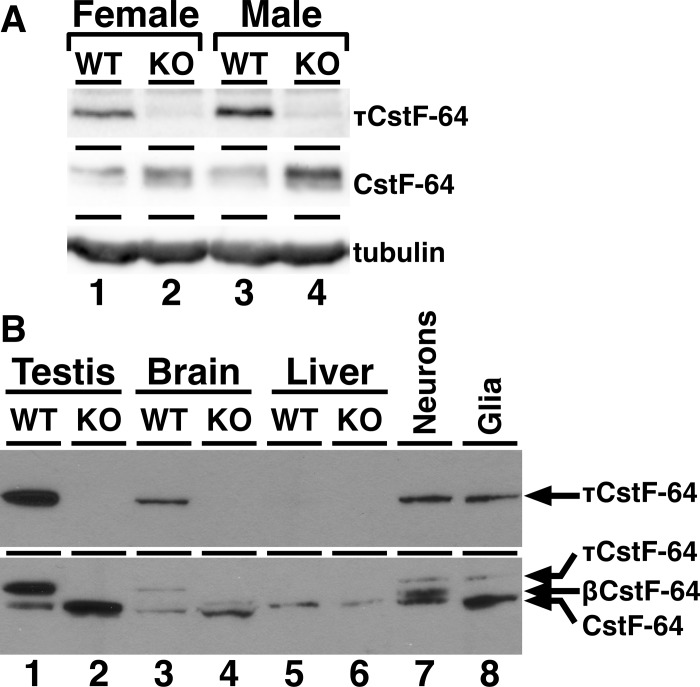
τCstF-64 and CstF-64 are expressed in brains of adult mice.(A) Brain tissue extracts were separated by 10% SDS-PAGE and probed with antibodies that recognized τCstF-64 (Bethyl A301-487A, top panel), CstF-64 (3A7, middle panel), or β-tubulin (E7, bottom panel). Lanes were loaded with 10 μg total brain extract; lanes 1, female wild type; lanes 2, female Cstf2t-/-; lanes 3, male wild type; lanes 4, male Cstf2t-/-. (B) Testis (lanes 1, 2), brain (lanes 3, 4), and liver (lanes 5, 6) from wild type (lanes 1, 3, 5) or Cstf2t-/- (lanes 2, 4, 6) male mice were separated by SDS-PAGE as in 1A. Extracts from primary rat neurons (lane 7) and rat C6 glioma cells (lane 8) were included for comparison. Blots were probed with anti-τCstF-64 (6A9, top panel), and then subsequently re-probed with anti-CstF-64 (3A7, bottom panel) antibodies. Apparent migrations of τCstF-64, CstF-64, and βCstF-64 are indicated by arrows.